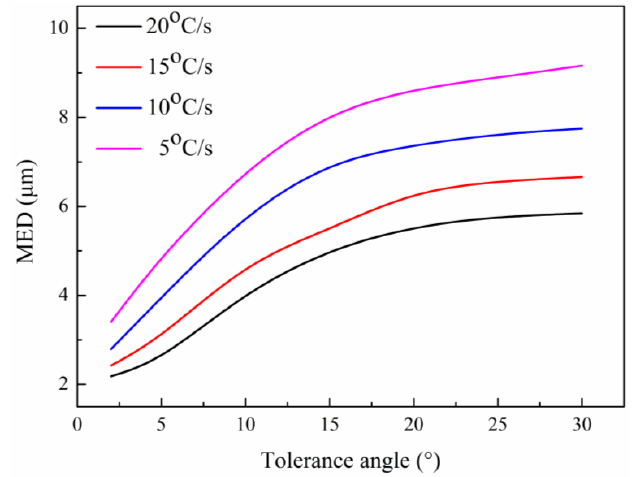
Figure 9. EBSD MED of QPF and GBF grains as a function of MTA and cooling process. MED—mean equivalent diameter, MTA—misorientation tolerance angle, QPF—quasi-polygonal ferrite and GBF—granular bainitic ferrite.